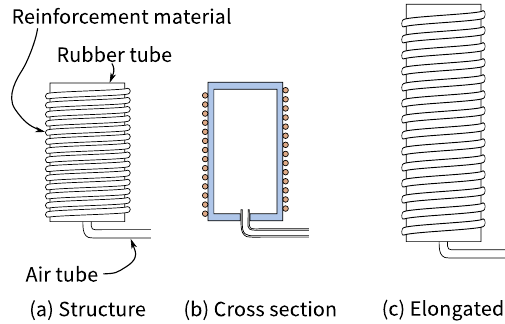
Figure 1. Structure of a coil-reinforced soft actuator.